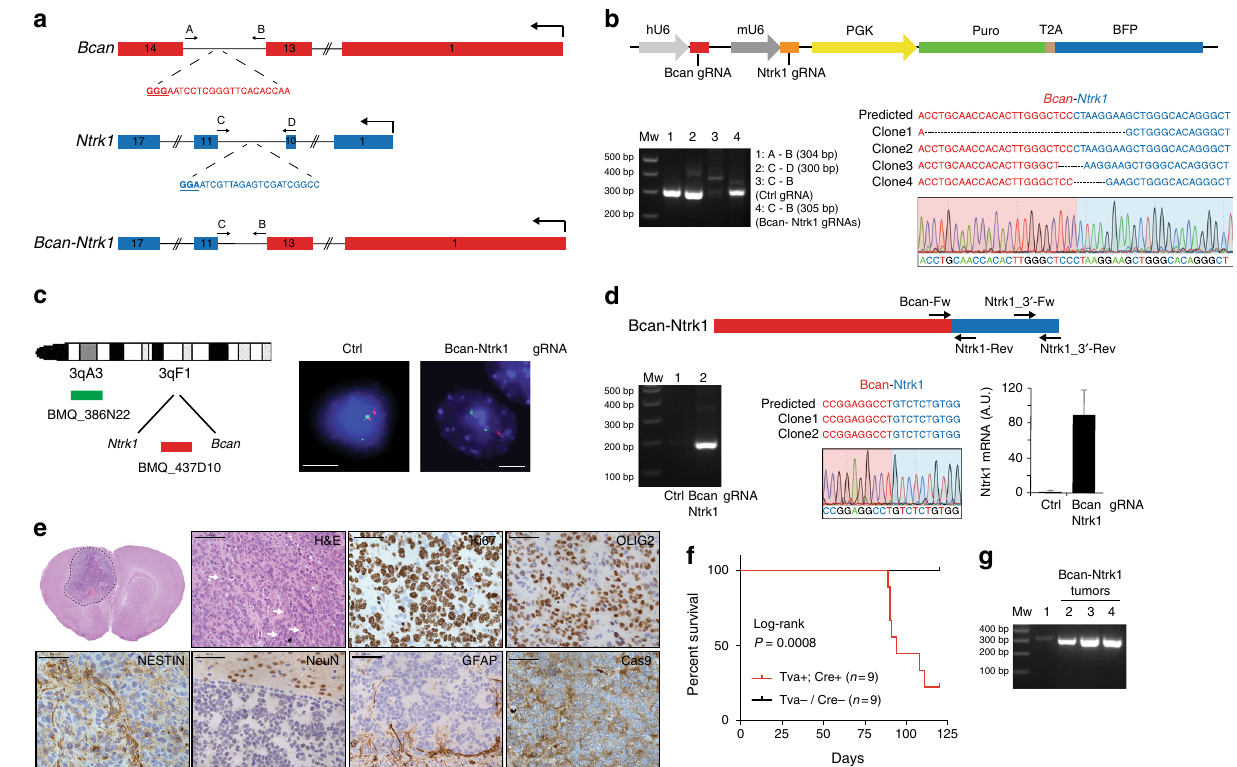
Fig. 4 Bcan-Ntrk1 gene fusion drives high-grade glioma formation. a Schematic representation of the Bcan and Ntrk1 gene loci and the Bcan-Ntrk1 gene fusion. Indicated are the gRNAs targeting both genes and the primers used for the PCR ampli fi cation of the indicated genomic regions. b Top panel: RCAS- gRNA-pair vector expressing the Bcan and Ntrk1 gRNAs. Bottom panels: PCRs were performed with the speci fi ed primers on genomic DNA extracted from the p53-null TVA-Cas9 NSCs transduced with the indicated gRNAs. The PCR band for the Bcan-Ntrk1gRNA infected cells was sub-cloned and analyzed by Sanger sequencing. The sequences of four independent clones and a representative chromatogram are shown. c Left panel: Diagram of fl uorescence in situ hybridization (FISH) probe design. BAC clone BMQ-437D10 (red) is located within the deleted region and BMQ-386N22 (green) is used as a control of chromosome 3. Mouse BACs are represented as green and red bars. Right panels: Representative FISH results using the two-color probe designed to detect the Ntrk1-Bcan intergenic microdeletion. The control green signal was used to count the number of chromosomes 3. The loss of the red signals indicates the microdeletions. Scale bar: 5 μ m. d Top panel: Schematic representation of Bcan-Ntrk1 fusion transcript. Bottom panels: (left) RT-PCRs were performed on the mRNA from the p53-null TVA-Cas9 NSCs transduced with the indicated gRNAs, using the Bcan-Fw and Ntrk1-Rev primers; (middle) the PCR band was sub-cloned and the sequences of two independent clones and a representative chromatogram are shown; (right) qPCR, with the Ntrk1_3 ′ -Fw and Ntrk1_3 ′ -Rev primers, showing the upregulation of the Ntrk1 mRNA in the cells expressing the Bcan-Ntrk1 fusion. Data presented as mean ± SD ( n = 3); A.U. arbitrary unit. e H&E and IHCs using the indicated antibodies. White arrows point to mitotic fi gures. Scale bars: H&E 100 μ m; IHCs 50 μ m. f Kaplan Meier survival curves of RCAS-Bcan-Ntrk1-gRNA pair-induced gliomas generated in Gtv-a; hGFAP-Cre; LSL-Cas9; p53 lox/lox injected mice. Tva − or Cre − control littermates were used as injection controls. Log-rank P value = 0.0008. g A PCR performed on genomic DNA extracted from Bcan-Ntrk1 tumor tissues (lanes 2 – 4) con fi rmed the presence of the Bcan-Ntrk1 gene fusion. Genomic DNA from NSCs was used as a negative control (lane